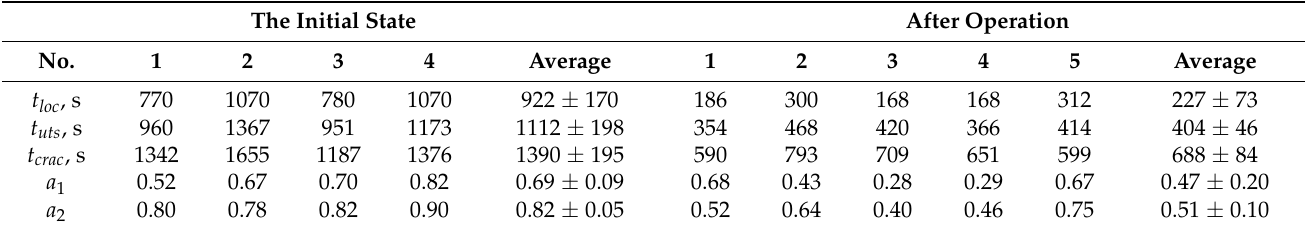
Table 2. The values of t loc , t crac and t uts for 0.2 C steel the studied samples. The Initial State After